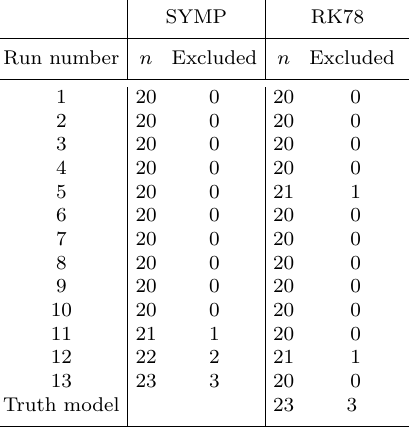
Table 3. Number of trajectories n with 4000 intersections and the number of trajec- tories excluded as not common to all